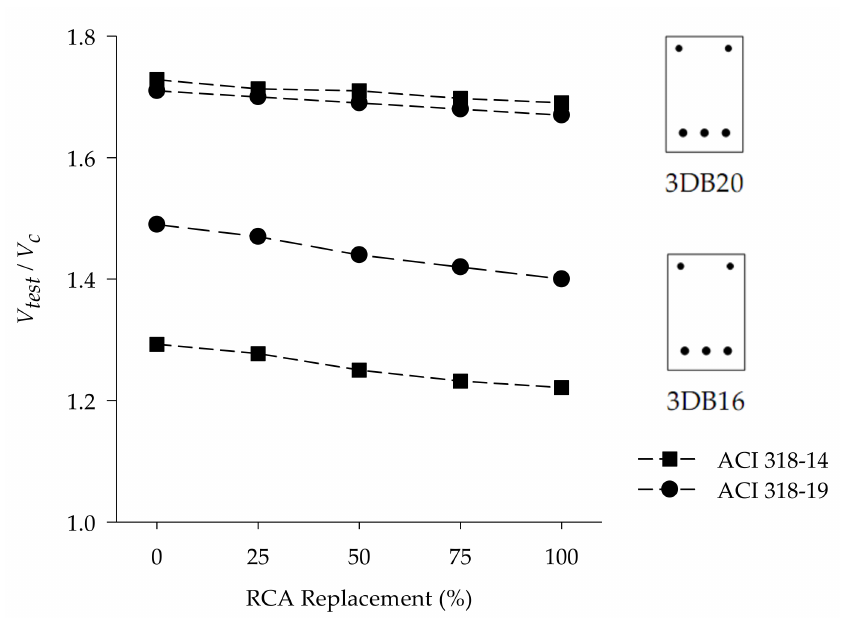
Figure 9. Ratios between ultimate shear from test and concrete shear prediction from ACI318 shear